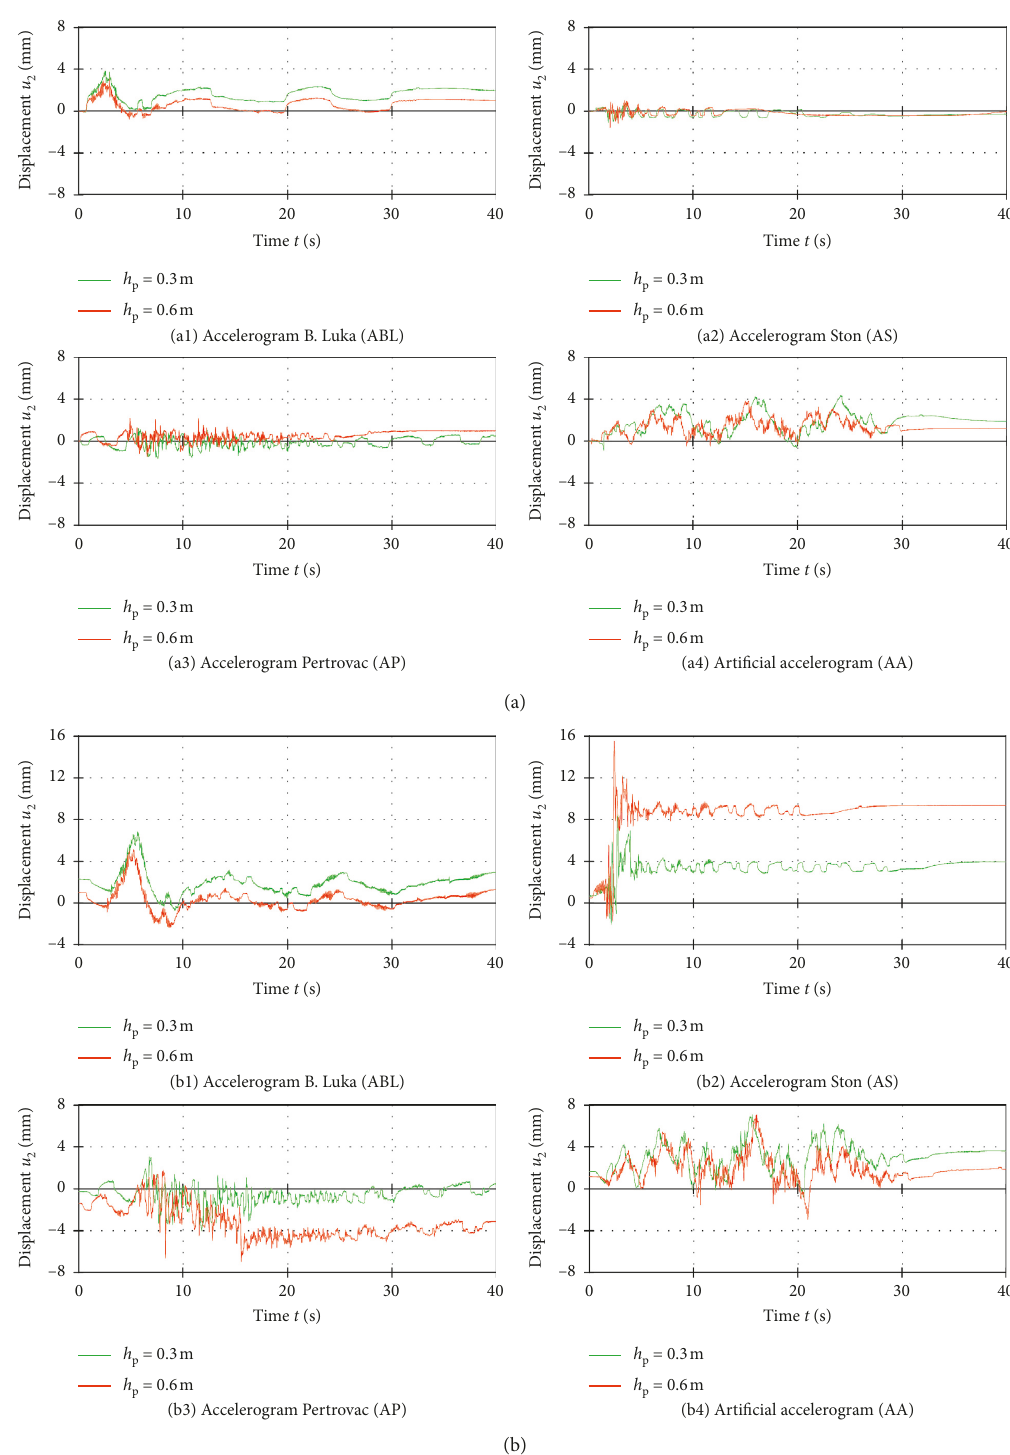
Figure 10: The effect of aseismic layer thickness on horizontal displacement u